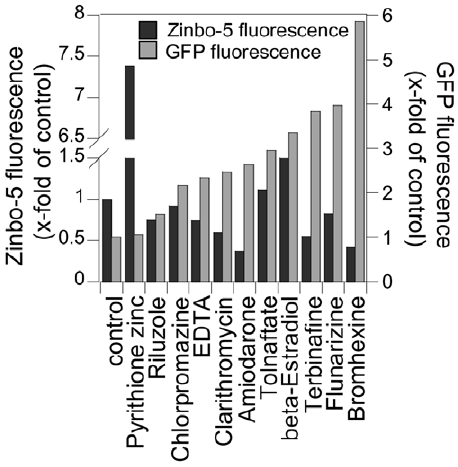
Figure 6. Validation of selected hits. A subset of hit compounds was subjected to flow cytometry analysis. Cells were treated with hit compounds and incubated for 20 hours at 30 u C. Labile zinc content was measured using the zinc fluorescent probe Zinbo-5. Zinbo-5 fluorescence was plotted in comparison to GFP fluorescence.